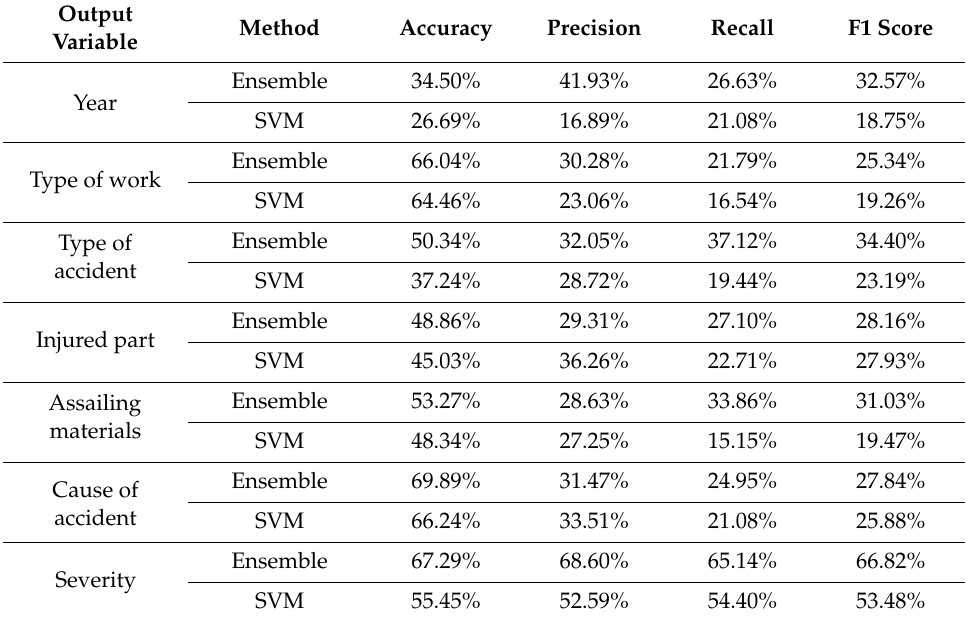
Table 5. Output performance in terms of accuracy, precision, recall, and F1